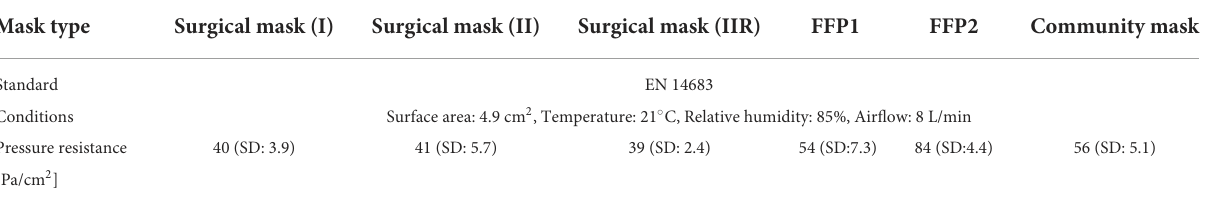
TABLE 3 Pressure resistance for surgical, FFP, and community masks based on EN 14683